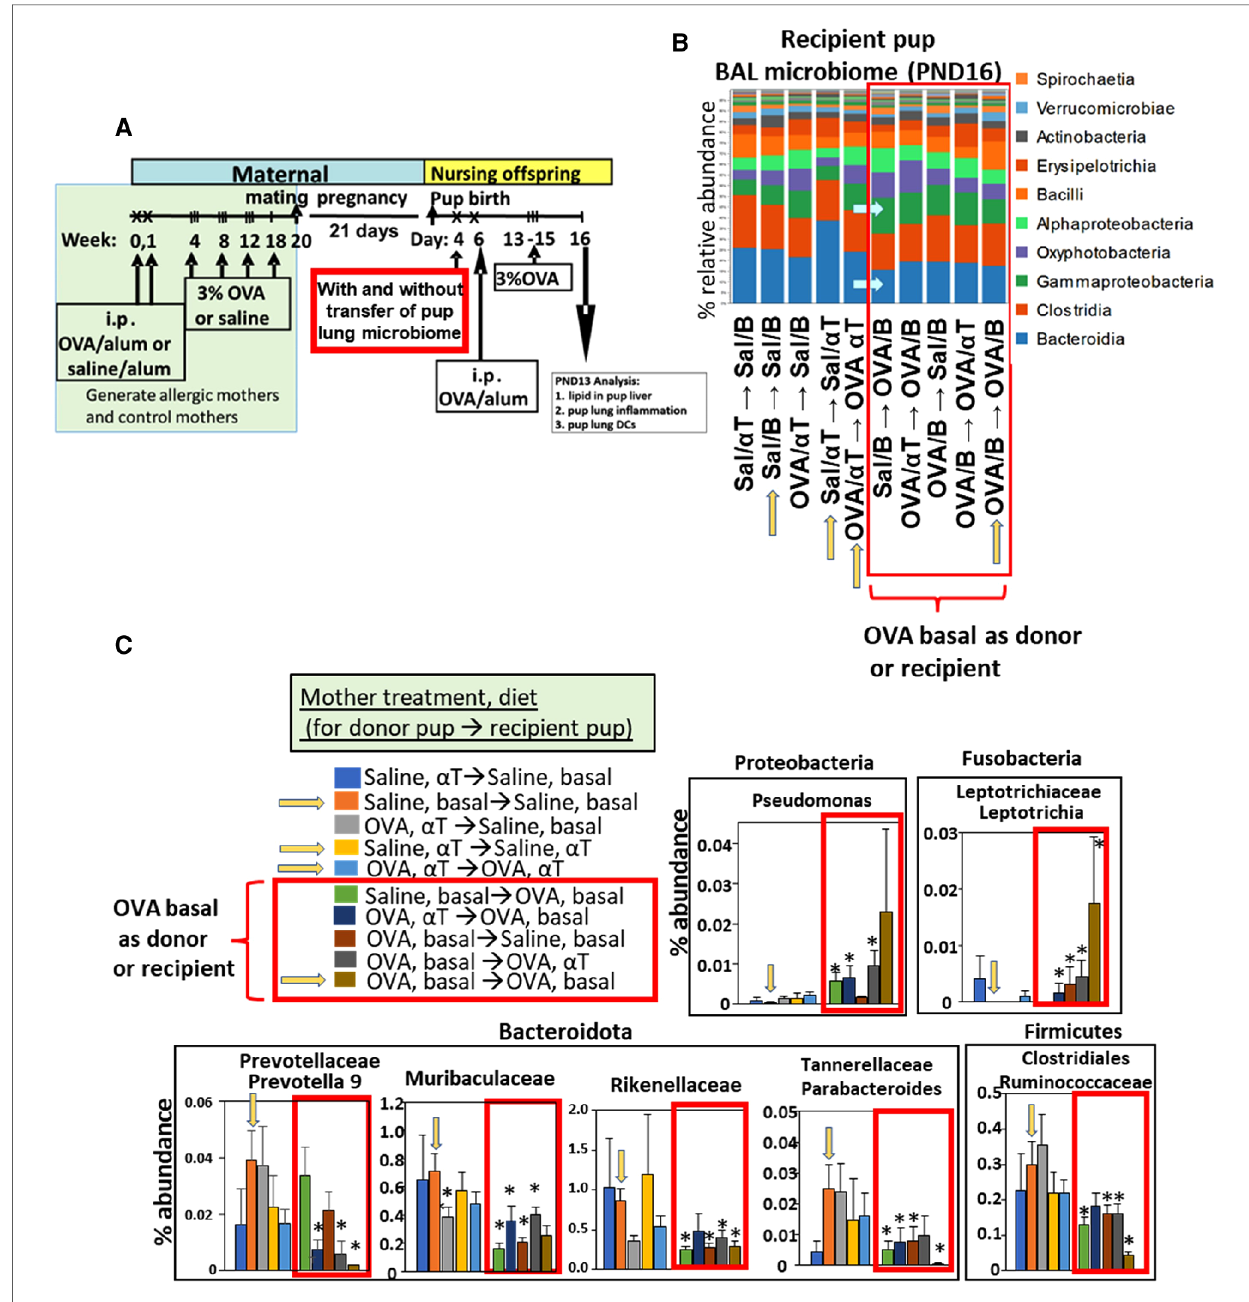
FIGURE 4 After intranasal microbiome transfers and airway allergen challenge, there was pup BAL microbiota with increased Proteobacteria and decreased Bacteroidota taxa for pups that were either recipient pups of mothers in the OVA,basal group or were pups receiving microbiome from pups of mothers in the OVA,basal group. ( A ) Timeline for treatment of mothers and pups. ( B ) Donor BAL microbiome was administered intranasally in 10 µl to PND4 recipient pups (as indicated in fi gures as the group of pups providing donor BAL microbiome for transfer into a recipient group of pups, i.e., donor → recipient group). Yellow arrows on the x-axis are those groups with donor and recipients within the same group. In RED BOX are groups with recipient or donor microbiota of PND16 pups of allergic mothers (OVA/basal). Blue arrows within panel B indicate that Bacteroidota are decreased and Gamma-Proteobacteria are increased in groups in red box. N =8/group. In panels B,C only, the OVA was in 0.09% saline; nevertheless, it did not alter the fold effect on BAL cell in fl ammation which is included in ( Figure 5 ) with data from 7 microbiome transfer experiments. ( C ) In RED BOX are recipient or donor microbiota of PND16 pups from allergic mothers (OVA/basal). Data are presented as percent abundance of bacteria taxa. *, p <0.05 as compared to Saline,basal → Saline,basal group (yellow arrow in graphs in C). Sal/B, saline-treated mother with basal diet. Sal/ α T, saline-treated mother with α T-supplemented diet. OVA/B, OVA allergen-treated mother with a basal diet. OVA/ α T, OVA allergen-treated mother with α T-supplemented